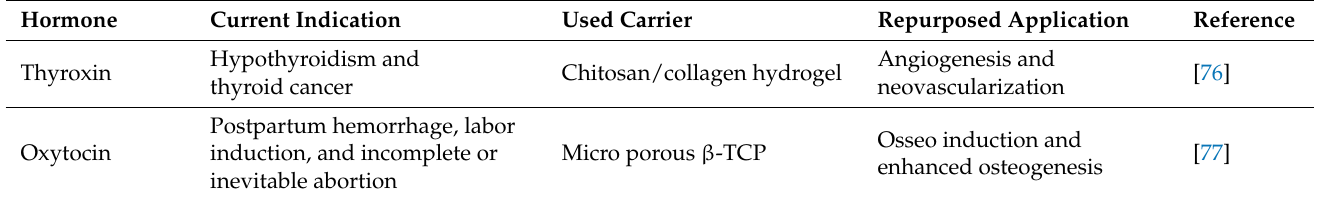
Table 4. Current research is focuses on various hormones locally applied for bone and periodontal tissue